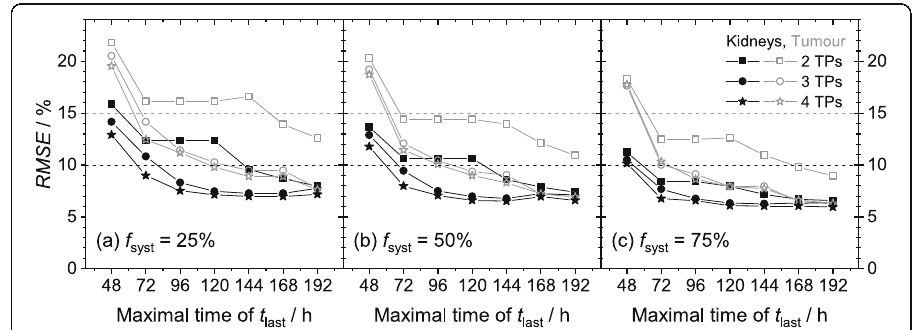
Fig. 4 Best achievable root-mean-squared error (RMSE) values as a function of the latest used measurement time t last for different fractions of systematic error f syst of a 25%, b 50% and c 75%. The RMSE of the kidneys (filled black) and the tumours (open grey) for different number of time points TPs (2: square; 3: circle; 4: star) are depicted. The horizontal lines represent RMSE = 10 % (black dashed) and RMSE = 15% (grey dashed) representing the ad hoc assumed limits for the kidneys and tumours,